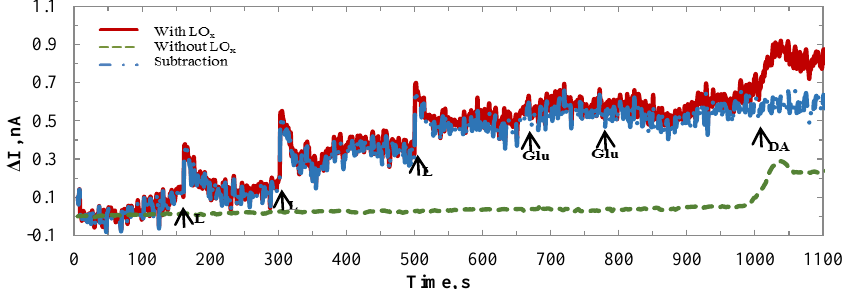
Figure 8. Time-current plots for WE (with LO x ) and SE (without LO x ) in 1 × PBS with responses to lactate, glutamate, and dopamine.